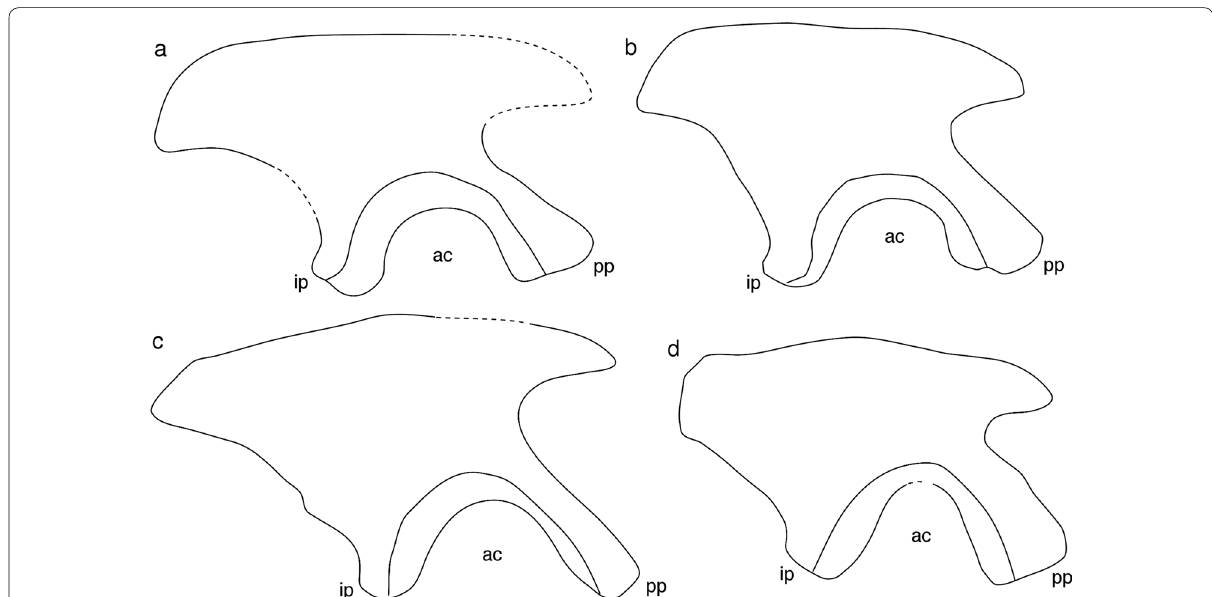
Fig. 18 Comparison of outlines of the right ilia of several non-sauropodan sauropodomorphs. a Reconstruction of the ilium of Schleitheimia . b Plateosaurus (based on Galton and Upchurch 2004). c Adeopapposaurus (left ilium reversed; based on Martínez 2009). d Lessemsaurus (based on Pol and Powell 2007b). ac, acetabulum; ip, ischial peduncle; pp, pubic peduncle. Not to scale; drawn to the same length over the pubic and